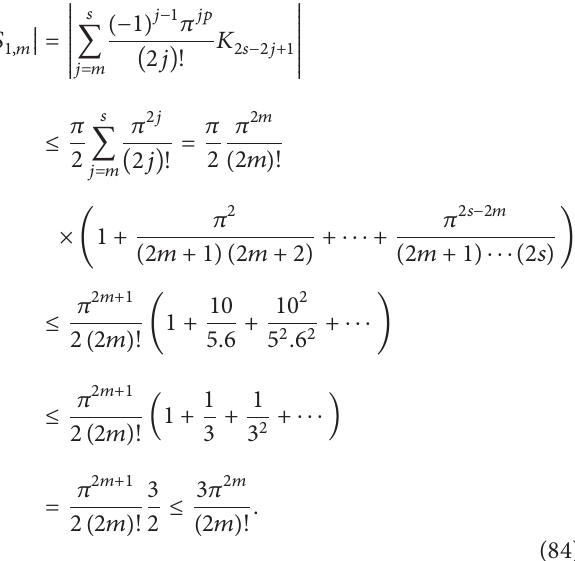
̃𝐴 (𝑥) , ̃𝐵 (𝑥) , and ̃𝐶 (𝑥) for 𝑥 = 𝜋/2, 𝜋 , by using formulas (65), (67), and (70), respectively. 𝑟 𝑟 𝑟 𝑟